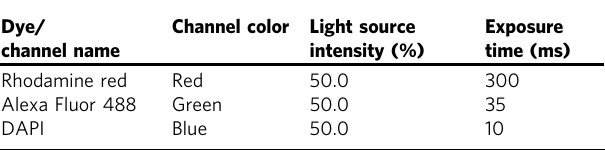
Table 1 CD47 antibody binding and macrophage-mediated